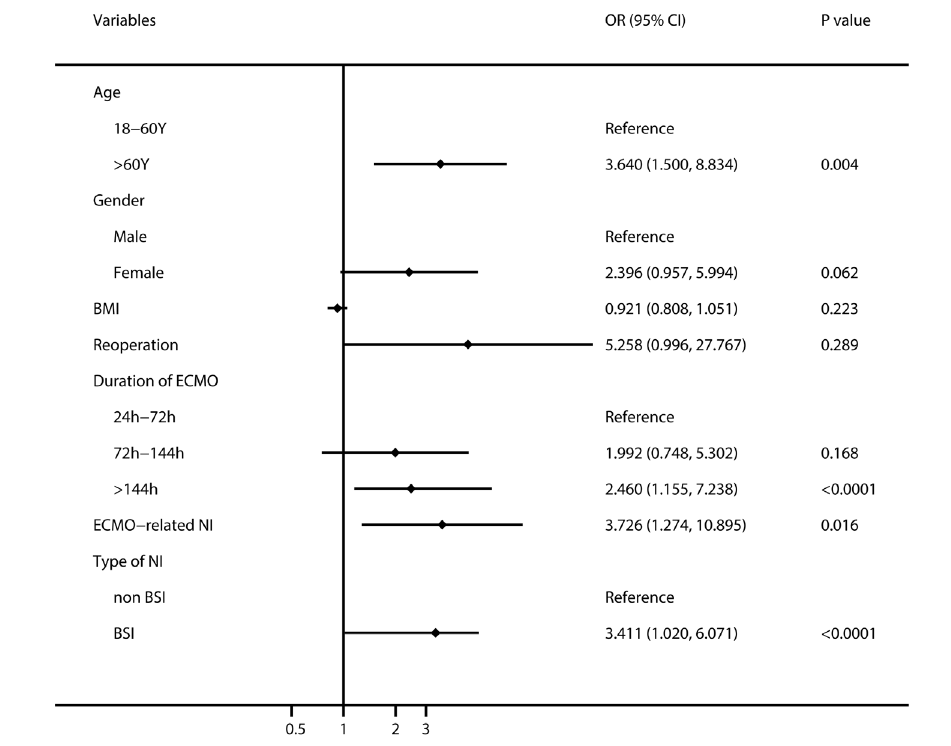
Fig. 5 - The multivariate logistic regression analysis of risk factors for in-hospital death. BMI=body mass index; BSI=blood stream infection; CI=confidence interval; ECMO=extracorporeal membrane oxygenation; NI=nosocomial infection; OR=odds